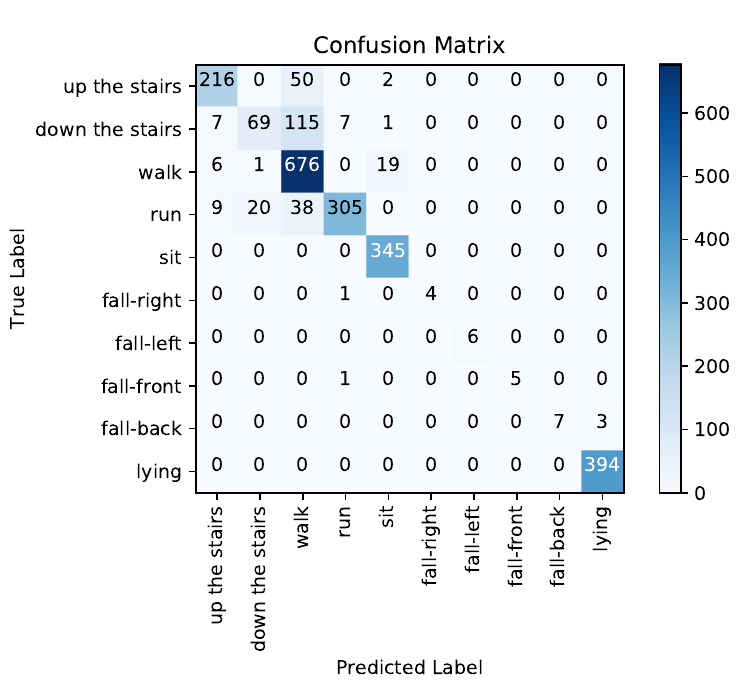
Figure 9. Confusion matrix using the automatic feature extraction based